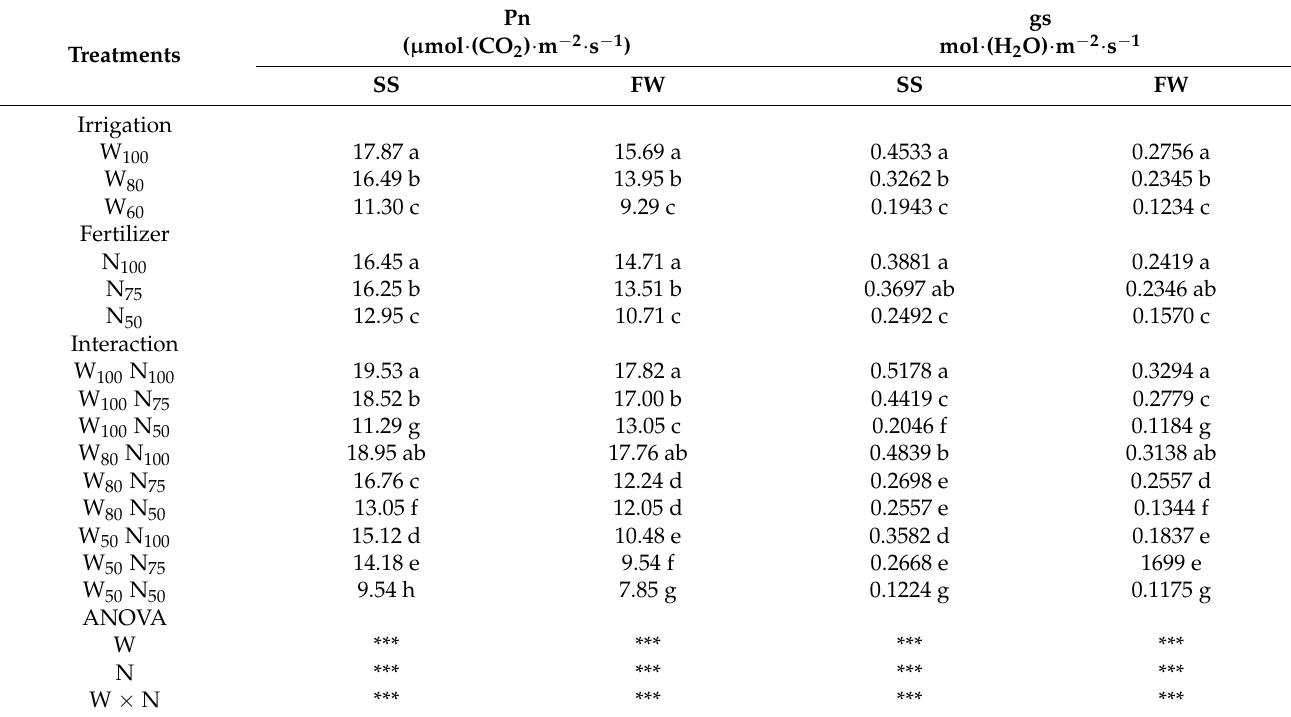
Table 4. Photosynthetic rate (Pn) and stomatal conductance (gs) across irrigation levels with different nitrogen concentration applied levels during the spring–summer (SS) and fall–winter (FW) season.